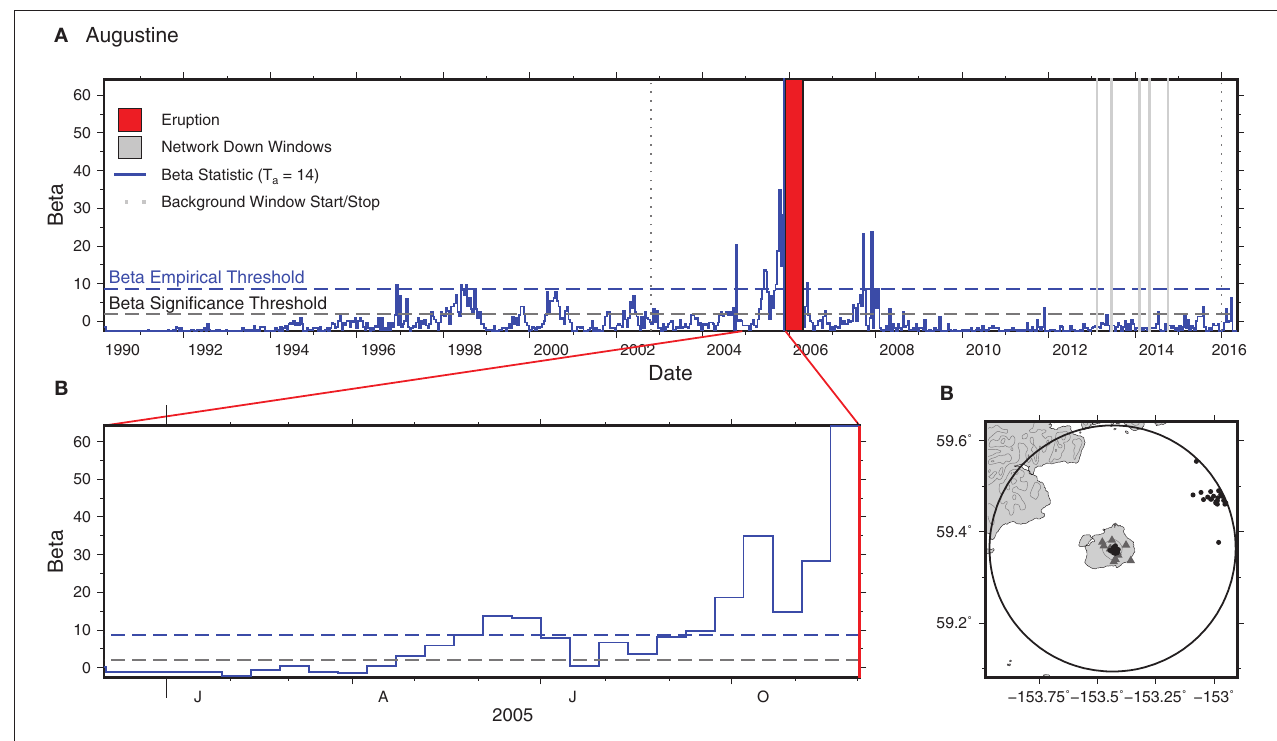
FIGURE 2 | Example of the β -statistic as applied to Augustine volcano. (A) Results ( T a = 14 days) over the entire time period of analysis. (B) Zoomed version of (A) beginning 1 year before the 2006 eruption. (C) Locations for events (black dots) within T a = 14 days of the eruption. Dark gray triangles show locations of nearby seismic stations. Black circle shows search radius ( R = 30km) from the volcanic center. Topography contours (300m interval) are shown in gray.